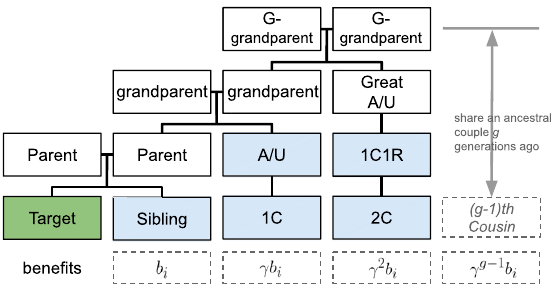
Figure 1. An illustration of discounting benefits for different degrees of relatedness between players. 1C: first cousin; 1C1R: first cousin once removed, and so forth. Relationships shaded in blue are considered relevant when searching for